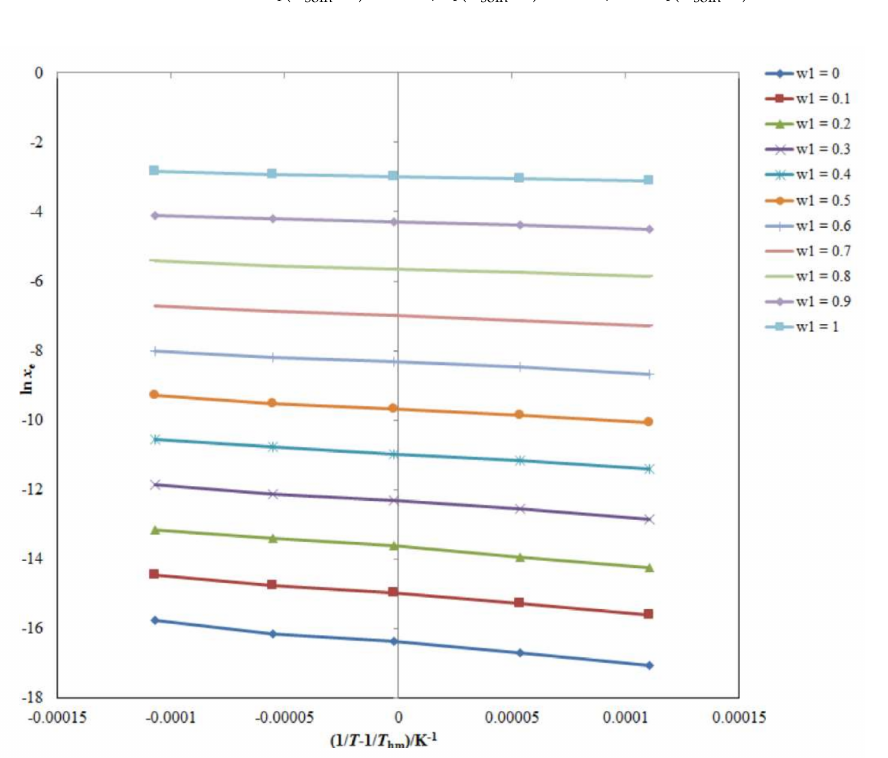
Figure 3. Van’t Hoff curves for logarithmic solubility of CNZ (3) in aqueous mixtures of TP (1) and water